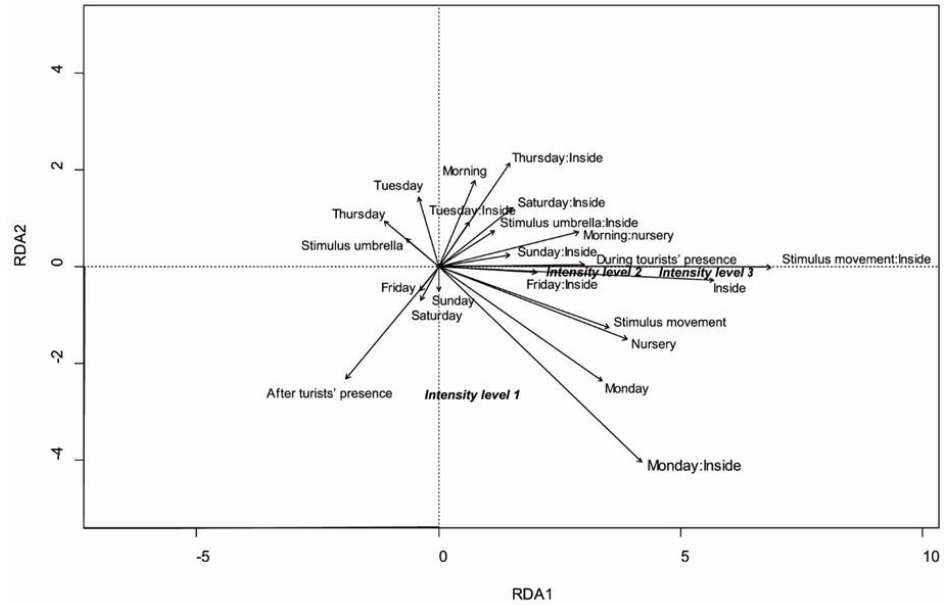
Figure 8. Redundancy analysis graph of the matrix “stimulus × number of animals’ responses per level of intensity”, using the following variables: type of stimulus, inside/outside, day of the week, time of the day (morning/afternoon), group type (nursery group or males), exposure to tourists (before, during or after tourists’ presence) and the interaction between the type of stimulus and inside/outside.